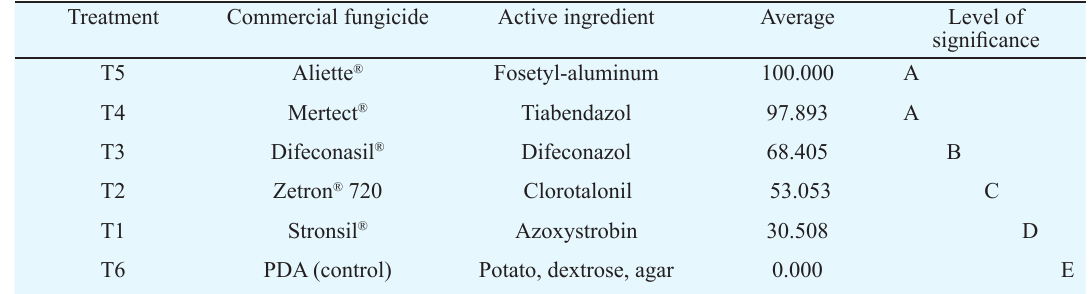
Treatment Commercial fungicide Active ingredient